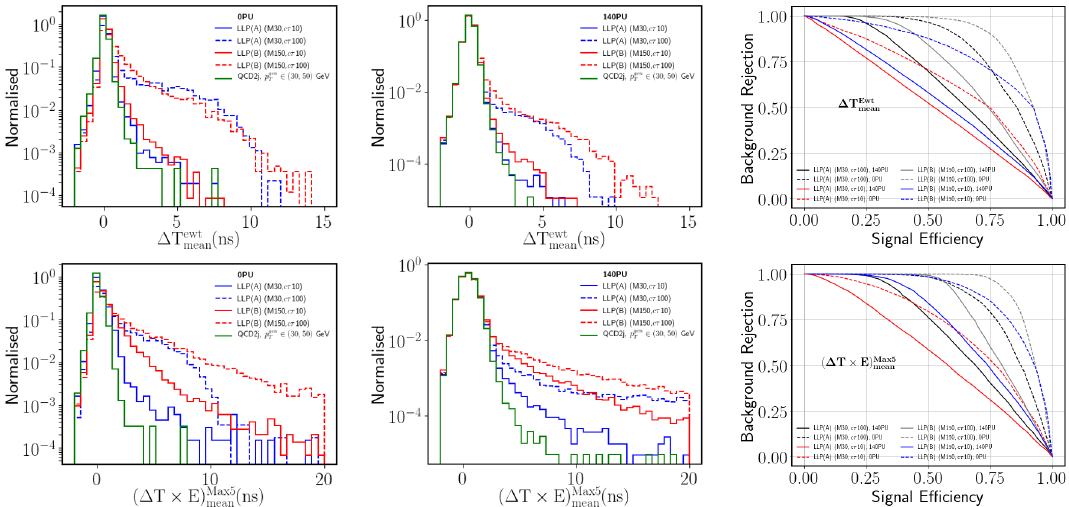
( top ) and mean value of time mean mean ∈ { 30 , 50 } GeV T